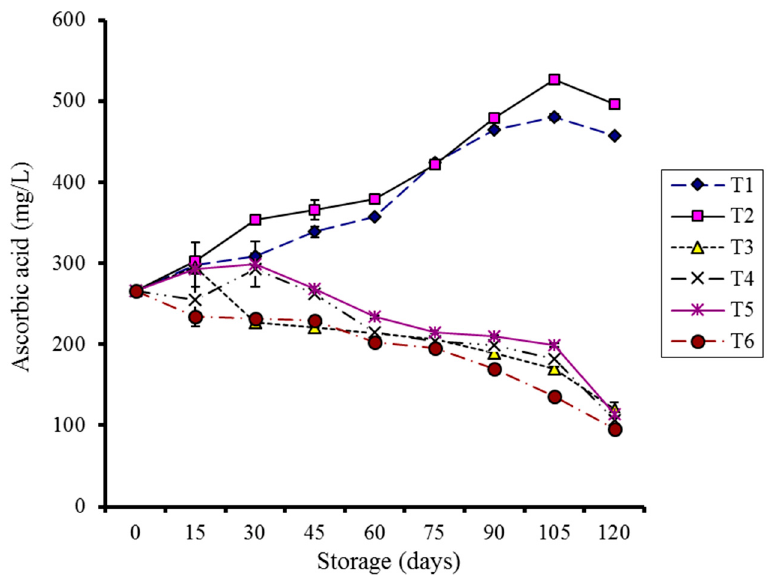
Figure 7. Effect of CMC and guargum-based silver nanoparticle coatings on the ascorbic acid of kinnow fruit stored at 4 and 10 °C during storage. The vertical bars represent standard error of the means. Values represented as mean ± SE of three replicates.